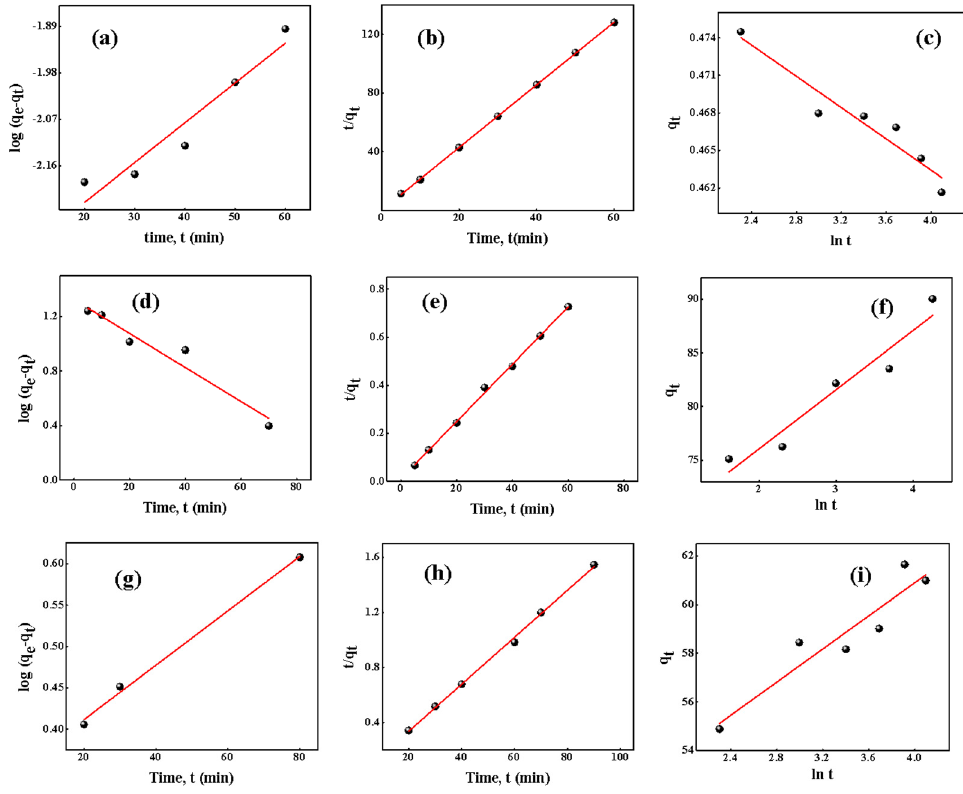
Figure 9. ( a – c ) Pseudo-first-order, pseudo-second-order and elovich models for BG. ( d – f ) Pseudo- first-order, pseudo-second-order and elovich models for MG. ( g – i ) Pseudo-first-order, pseudo-second-order and elovich models for CR. Table 4. Kinetic constants for all three models used in study.